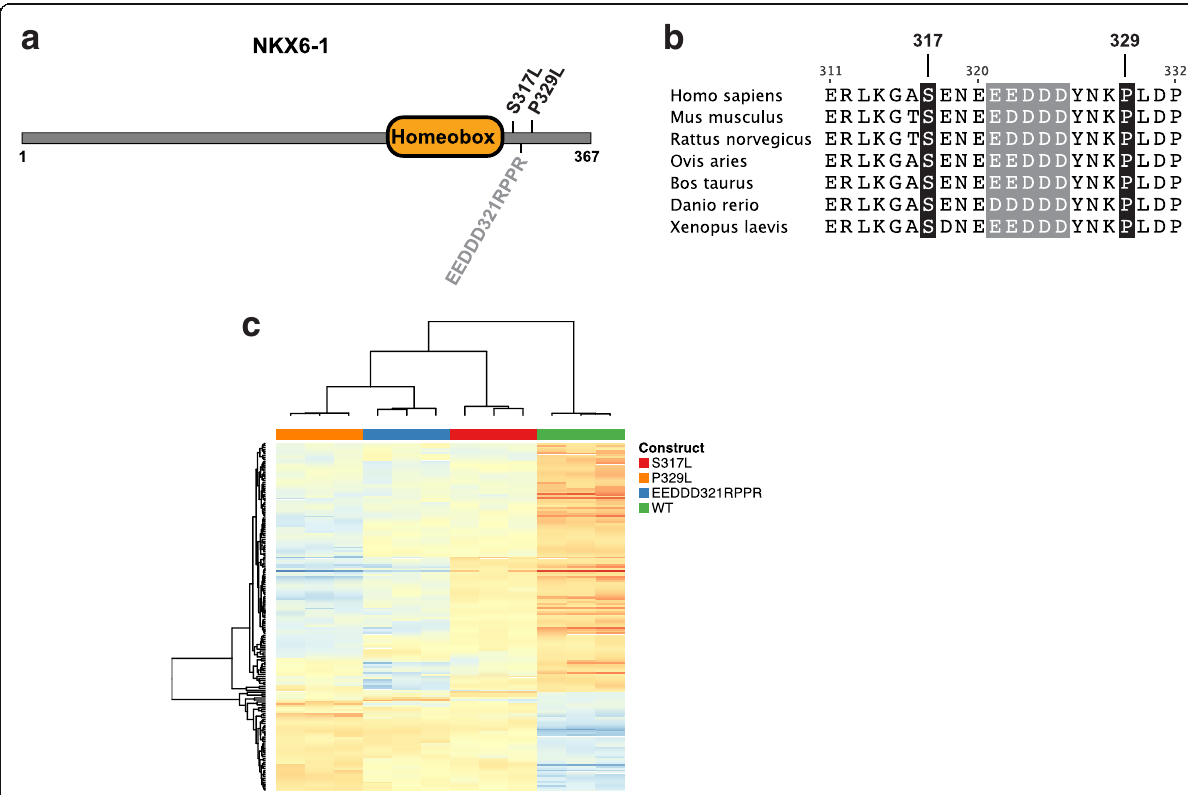
Fig. 4 Functional analysis of NKX6 – 1 variants. a MODY relevant NKX6 – 1 variants. Numbers indicate amino acid position. b Multiple sequence alignment of NKX6 – 1 from the indicated species. c Heatmap of differentially expressed genes identified by comparing each mutant against wild-type in cells expressing the indicated variant or wildtype NKX6 – 1. EEDDD321RPPR is a control variant